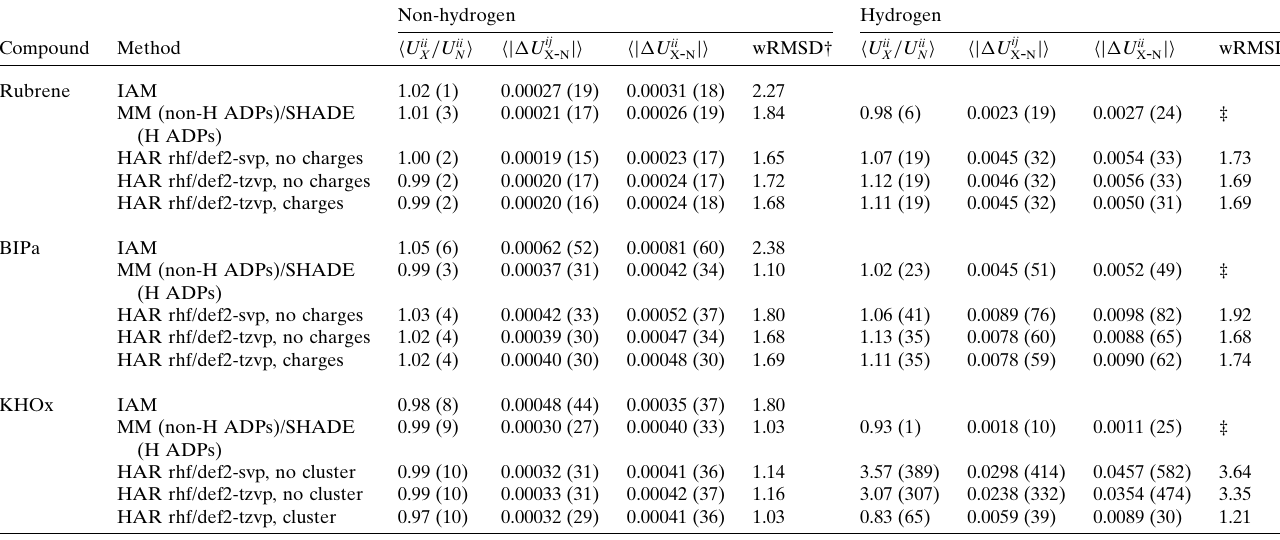
Table 4 Comparison of X-ray and neutron ADPs for rubrene, BIPa and KHOx from IAM, MM and HAR models. h U ii i is the mean ratio of the diagonal X-ray and neutron ADPs. hj (cid:2) U ij = U ii X N ADPs (units A˚ 2 ). wRMSD is the weighted root-mean-squared difference as defined in equation (1). Charges = a cluster of point charges and dipoles. Cluster = an explicit cluster of ions around the central ion pair. Values in brackets are the sample standard